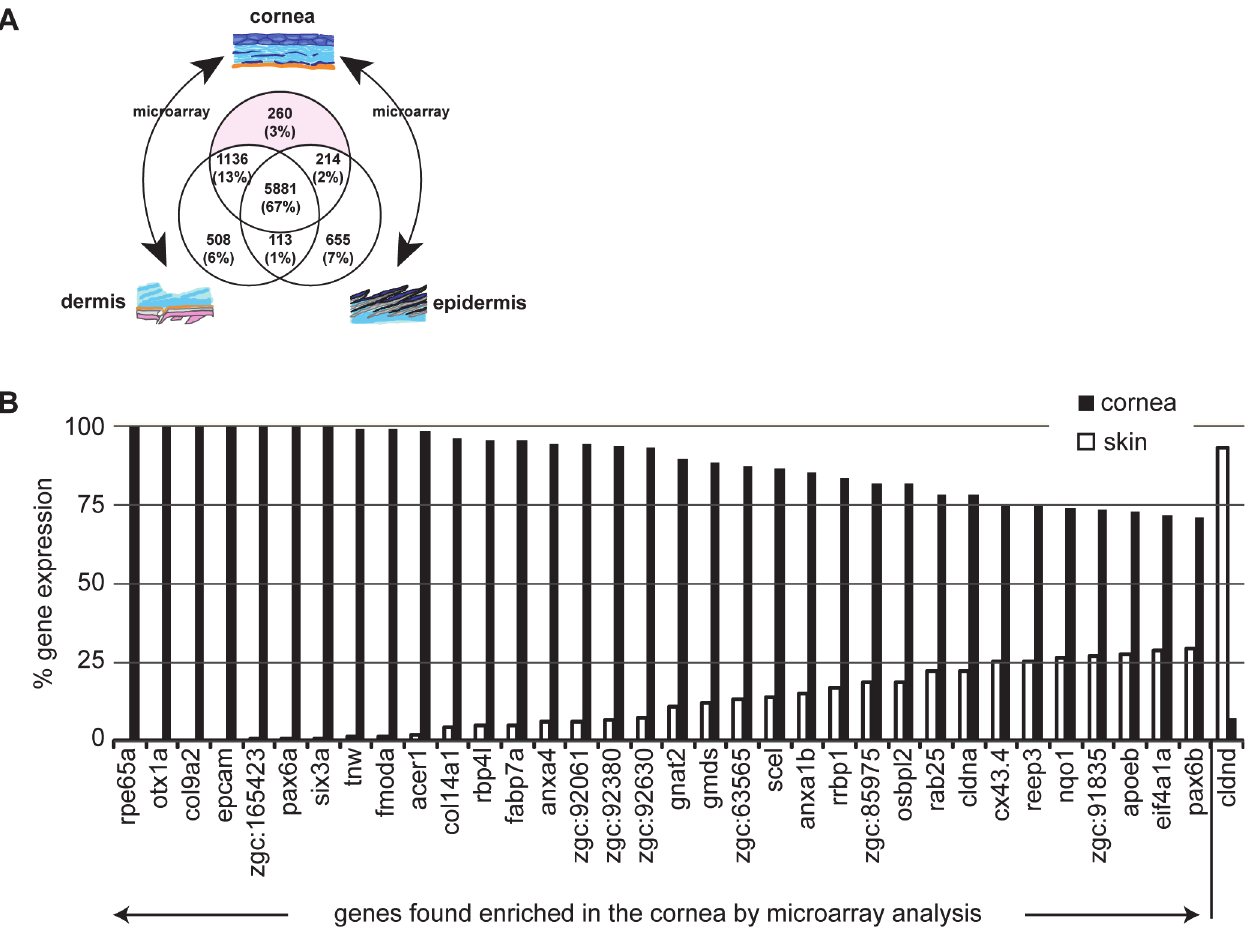
Fig 1. Identification of genes expressed in the adult zebrafish cornea. (A) Summary of the microarray results. In total 260 genes were found to be strongly expressed in the cornea relative to the dermis and epidermis. (B) RT-qPCR analysis of the gene expression in the cornea of adult zebrafish. Genes expressed differently between the two tissues in the microarray analysis (with fold change > 2 and adjusted p -value < 0.001) were selected and subjected to verification by RT-qPCR. Relative expression levels in the cornea (black columns) and the skin (white columns) are shown with the total expression level (cornea + skin) set to 100%. As an example for a gene enriched in the skin gene set, we chose cldnd ( claudin d ). All genes examined showed the correct direction of enrichment (three biological repeats, two tail unpaired t -test, p -adjusted < 0.05) thus verifying our microarray